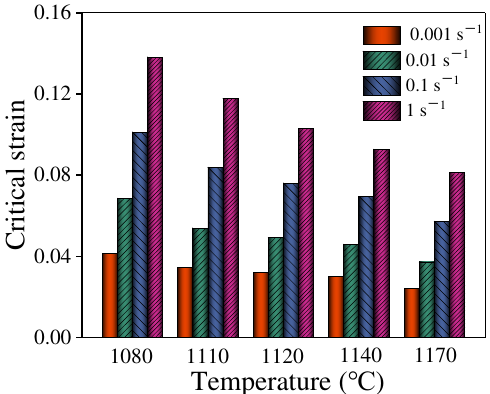
Figure 8. The column bars of ε c at different temperatures and strain rates. Generally, ε c can be evaluated by: where R is the constant for gas (8.314 J/(K·mol)). In addition, a 1 and Q 1 are material parameters, which can be decided by least square linear fitting of ln ε c –10,000/T and ln ε c − ln e ɺ plots, respectively, as displayed in Figure 9. Thus,